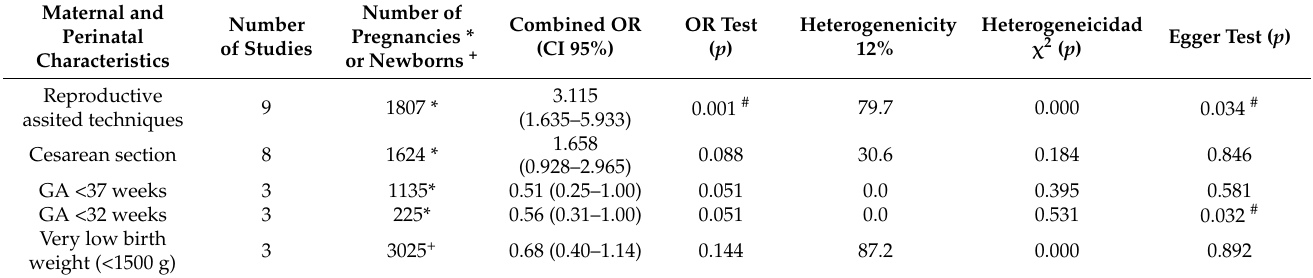
Table 7. Maternal y perinatal characteristics of the triplet pregnancies included in the meta-analysis according to chorionicity.